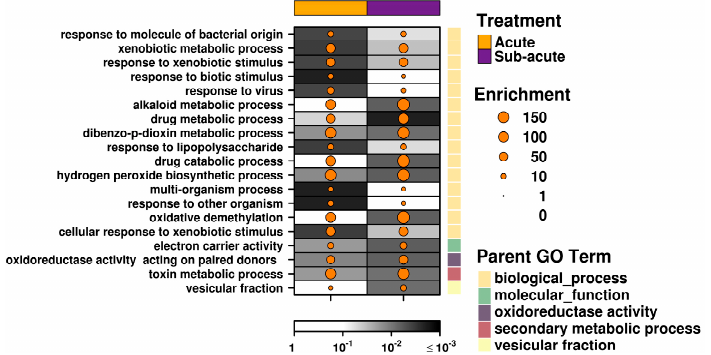
Figure 3. Pathway analysis. Genes which demonstrated significantly altered mRNA abundance (FDR < 0.05 and |log 2 fold change| > 0.5) following exposure to C2 were evaluated for pathway enrichment analysis. Pathways which showed significant enrichment (FDR < 0.01 and enrichment > 5 genes) in either the acute or subacute treatment groups are shown.